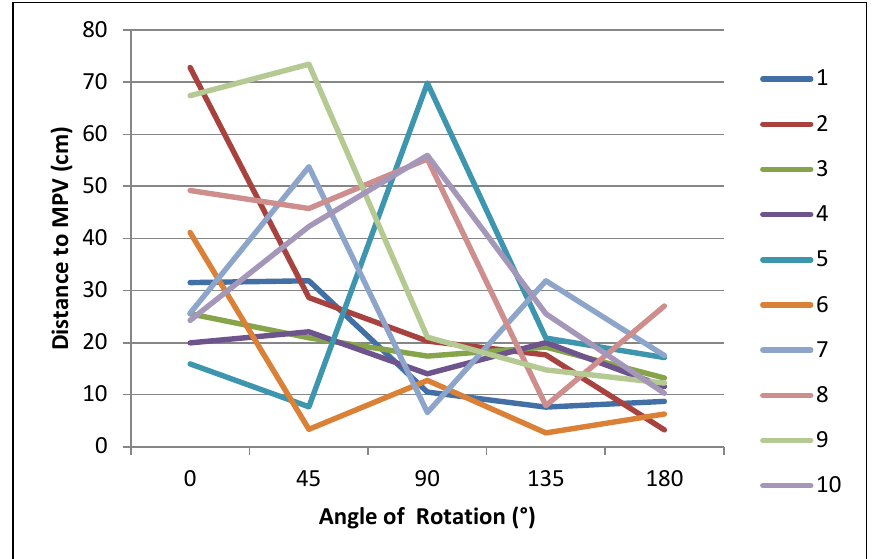
Figure 5. The change of distance (in cm) between MPV and correct position as the speaker is tilted from downward to upward orientation. Each color represents one check point. Vertical axis is distance measured in cm. Horizontal axis is angle of rotation with 0° being downward and 180° being upward. Note how accuracy increases as speaker angle approaches 180° (upwards). In all cases positioning accuracy remains